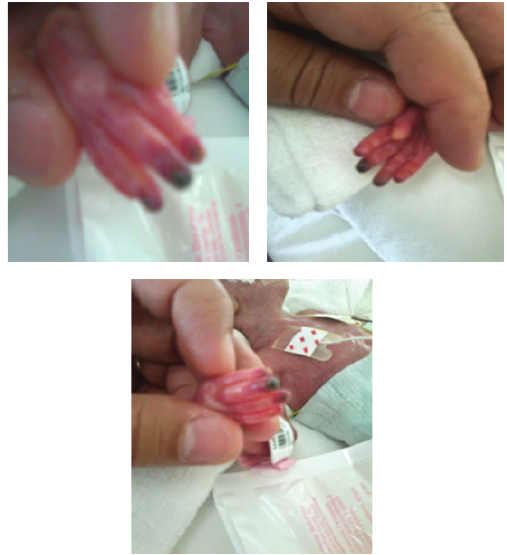
Figure 3: Resolving ischemia of the 2nd, 3rd, 4th and 5th fingers, 5 days after the ischemic event (dorsal and palmar aspects of the hand).